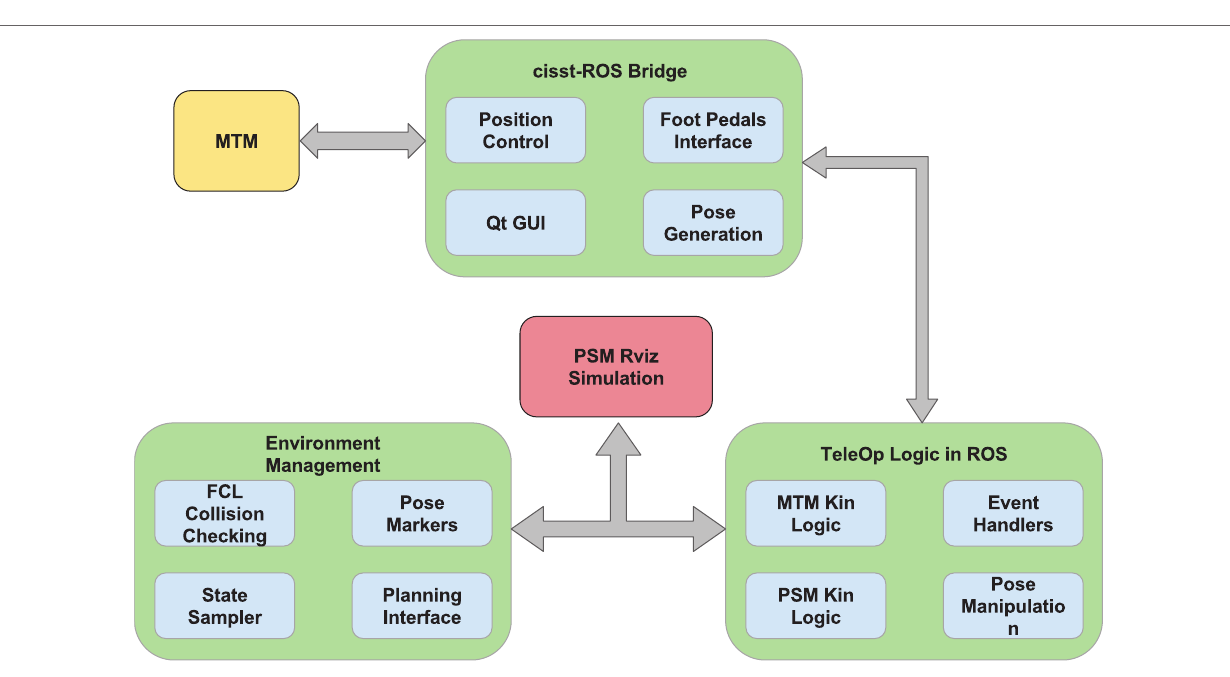
FIGURE 4 | Packages involved in teleoperation of simulated PSM using actual MTM